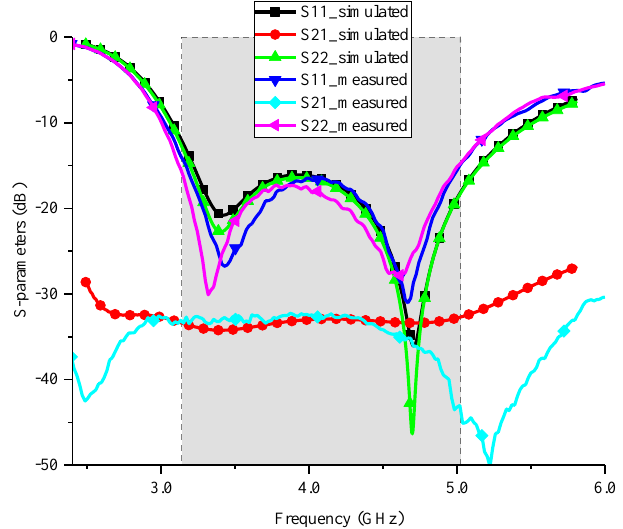
Figure 5. Measured and simulated S-parameters of the proposed antenna.